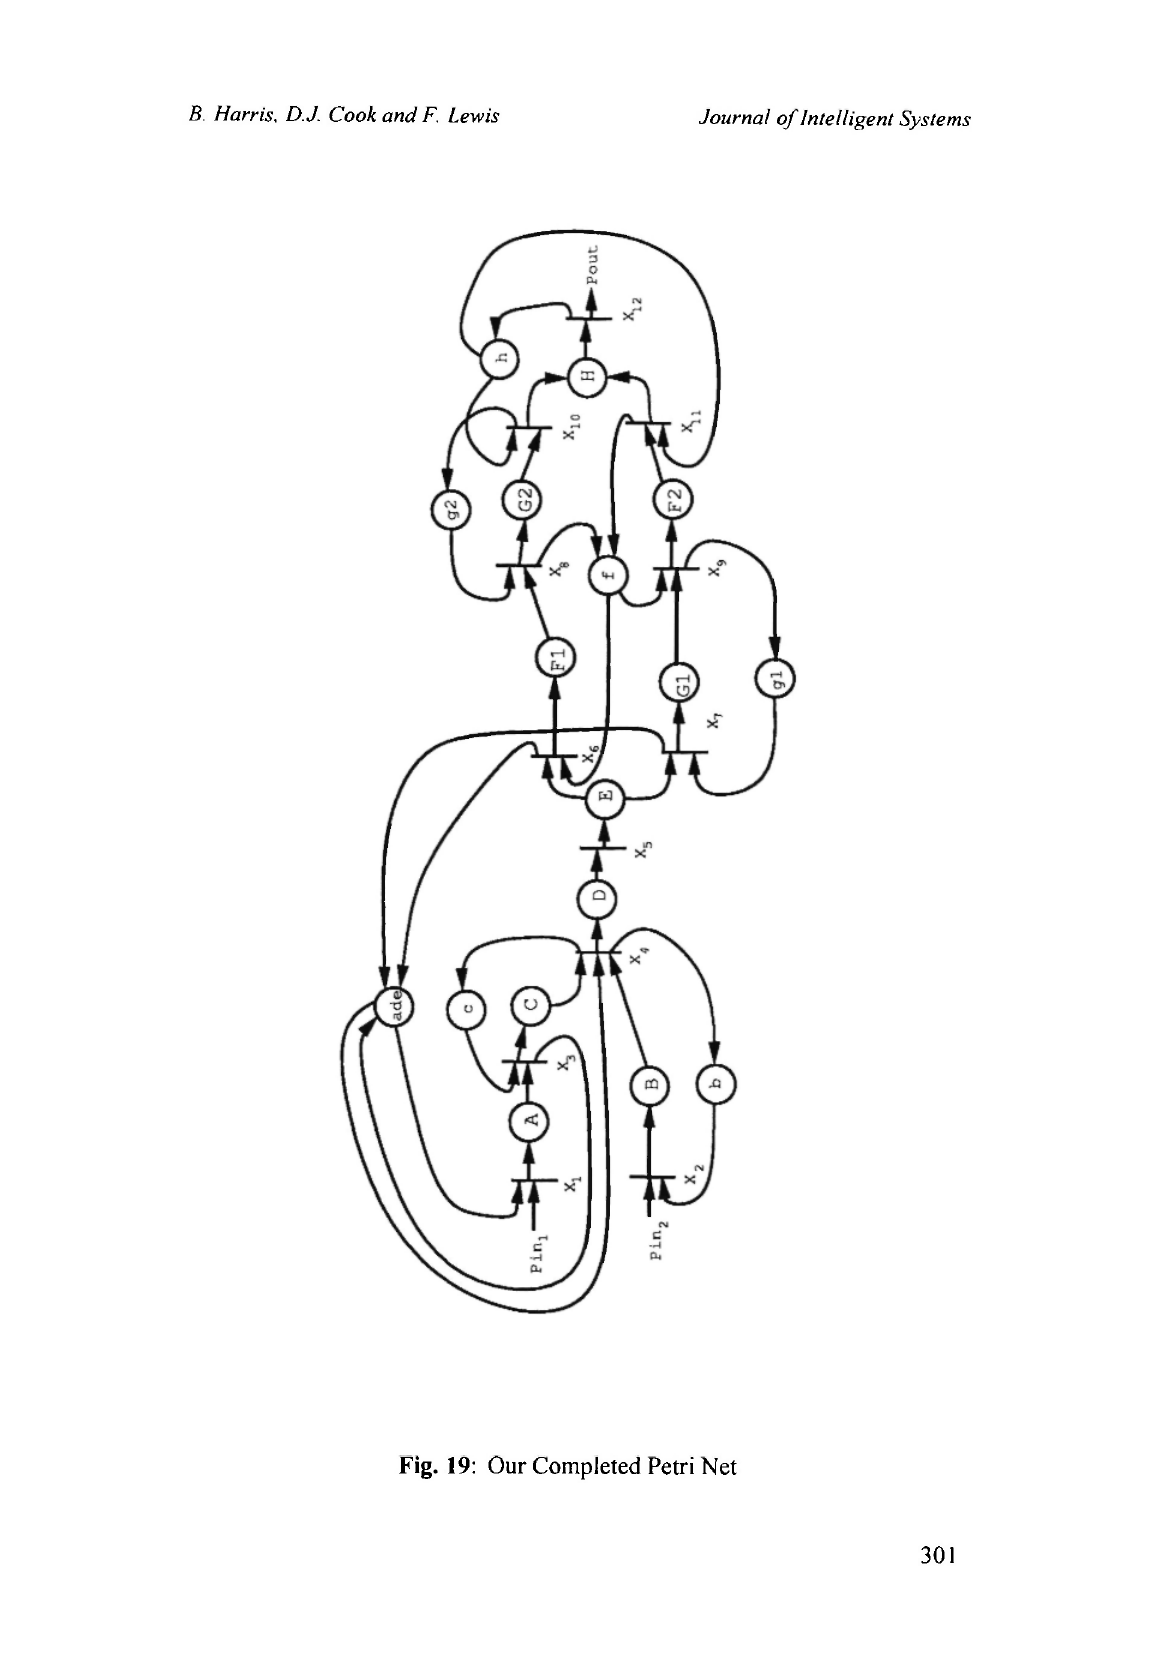
Fig. 19: Our Completed Petri